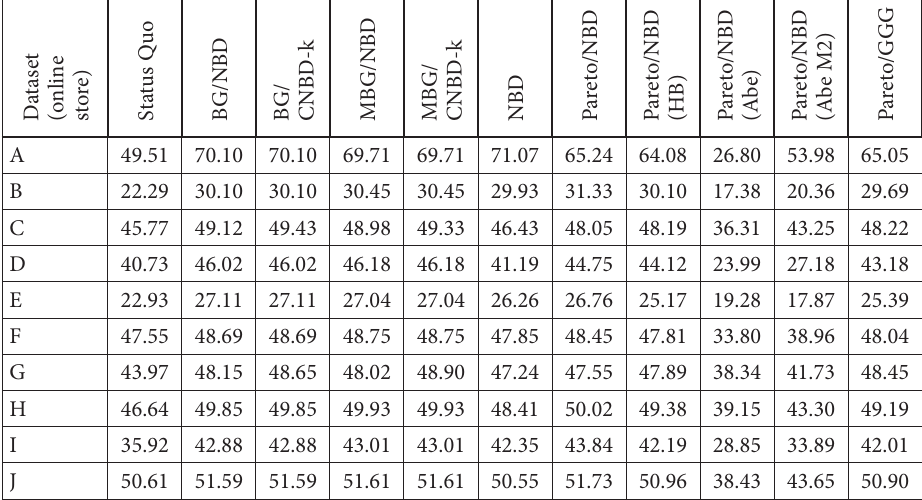
Table 7. Results for Sensitivity of selecting 10% of the most profitable customers (customer level, in